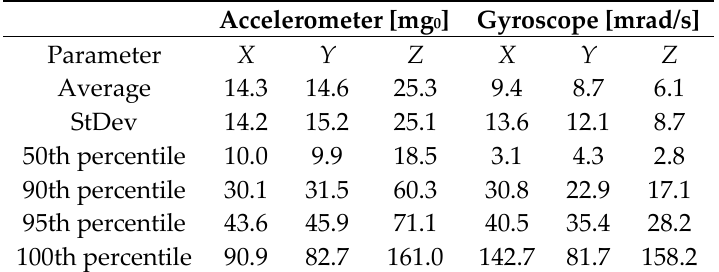
Figure 4. Accelerometer ( a ) and gyroscope ( b ) noise of all properly functioning devices ( K a = 108, K g = 82). The horizontal axis represents the device identification number from the measurement database. Considerable deviations are the result of different models of MEMS sensor chips embedded in different smartphone models. The vertical axis shows ( a ) VRW in [g 0 / Hz ] and ( b ) ARW in [deg/s/ Hz ]. Table 1. Statistical parameters of the measured smartphone accelerometer and gyroscope biases. Average, standard deviation and several percentiles for absolute bias values are